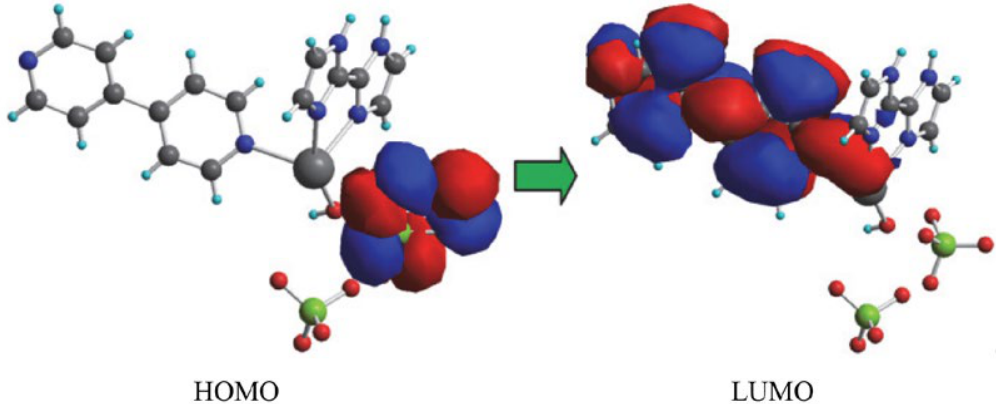
Figure 5. The electron-density population of complex 1 . The isosurfaces correspond to the electronic density differences of –10 e nm –3 (blue) and +10 e nm –3